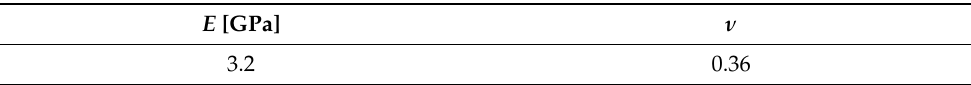
Figure 1. Dimensions of the tested CT specimens with the mechanized notch radii (0.25, 0.5, 1, 2 mm). Table 1. EPOLAM 2025 tensile